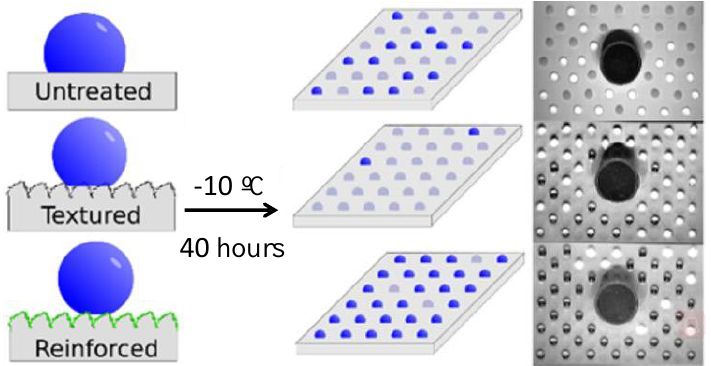
Figure 11. Reinforced superhydrophobic coating on silicone rubber for excellent anti-icing performance under −10 °C [195]; reproduced with permission from the American Chemical Society.